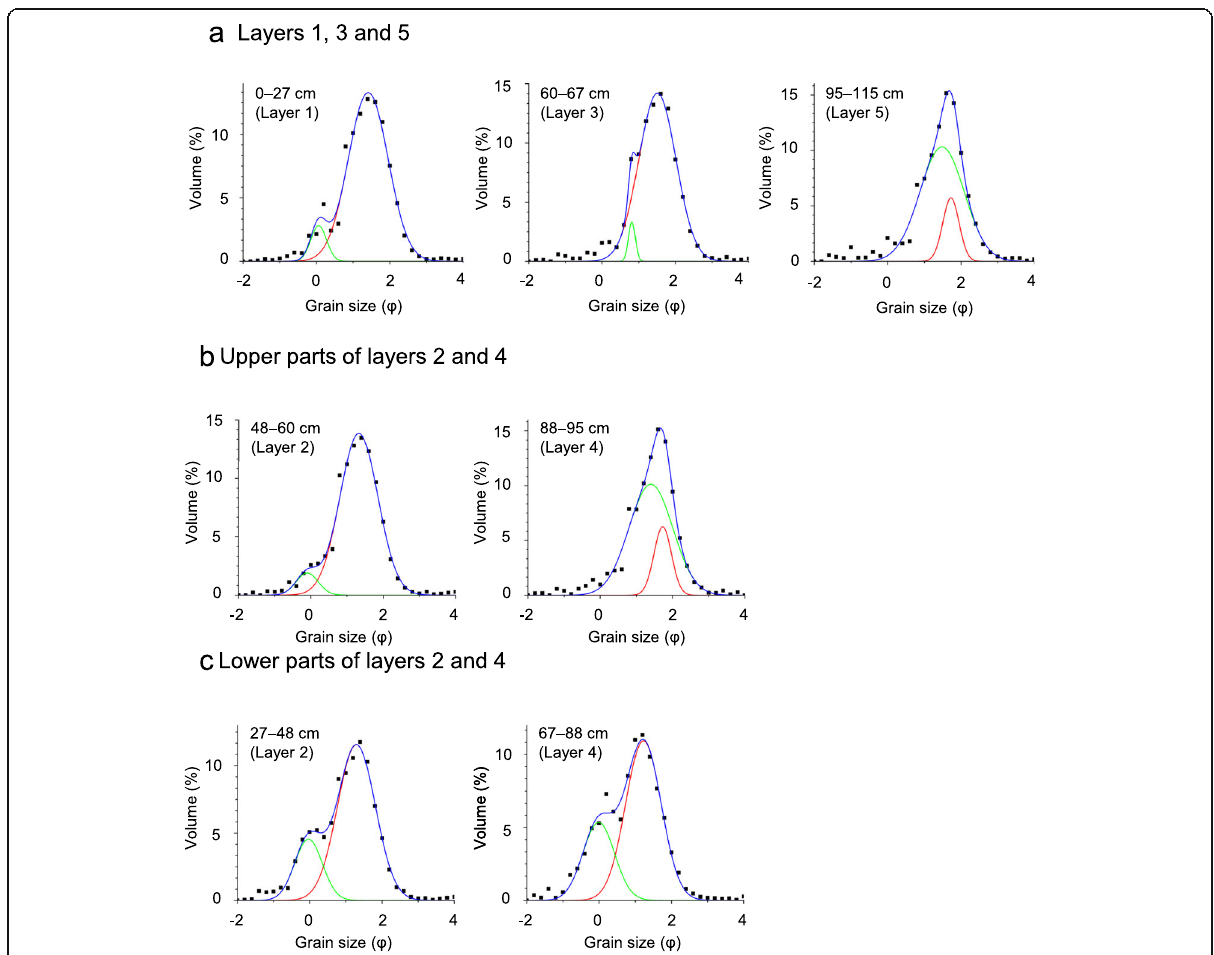
Fig. 6 Averaged grain size distribution of each layer: black squares, original data; blue lines, overall distribution against grain size; green lines, larger peaks; red lines, smaller peaks. These lines were produced by ORIGIN